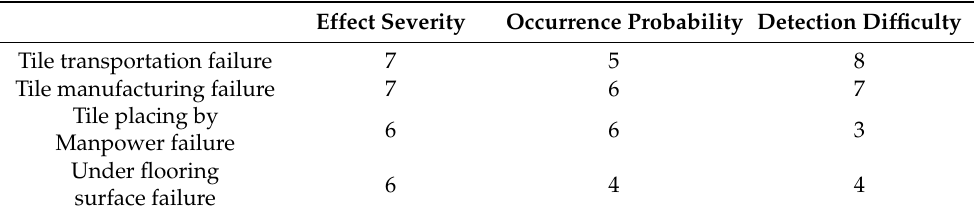
Figure 12. Trade ‐ off between cost and time for flooring task. Figure 12. Trade-off between cost and time for flooring task. Table 15. The decision matrix for identifying the most critical failure mode after improvement.